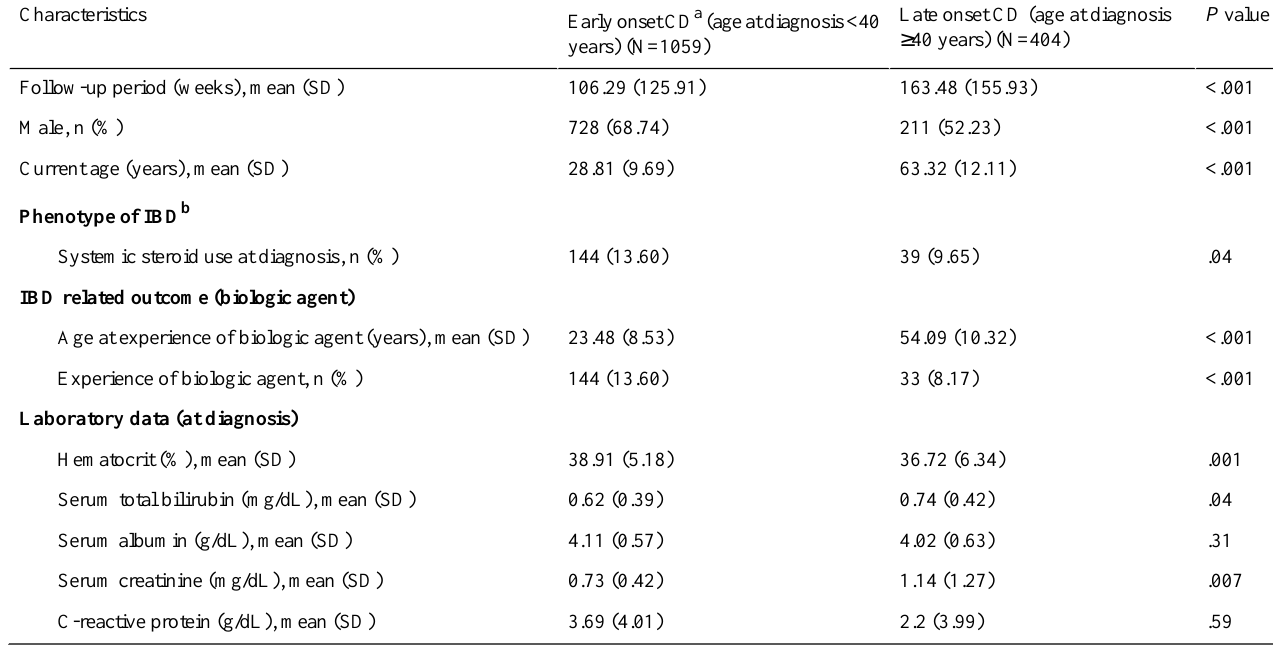
Table 3. Univariate Analysis of biologic agent experience between early onset and late onset group in Crohn's disease